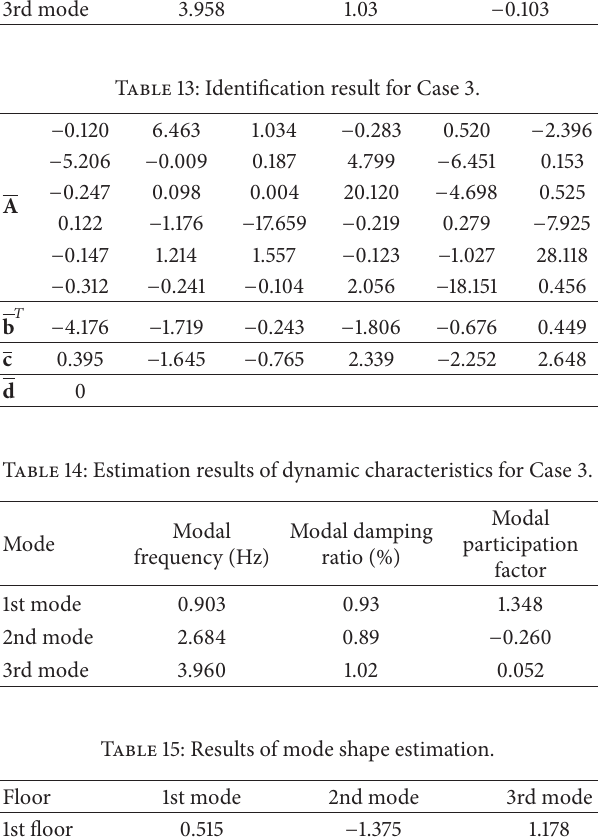
Figure 9: Comparison of the magnitude of frequency response functions (accelerances) for the first floor acceleration.